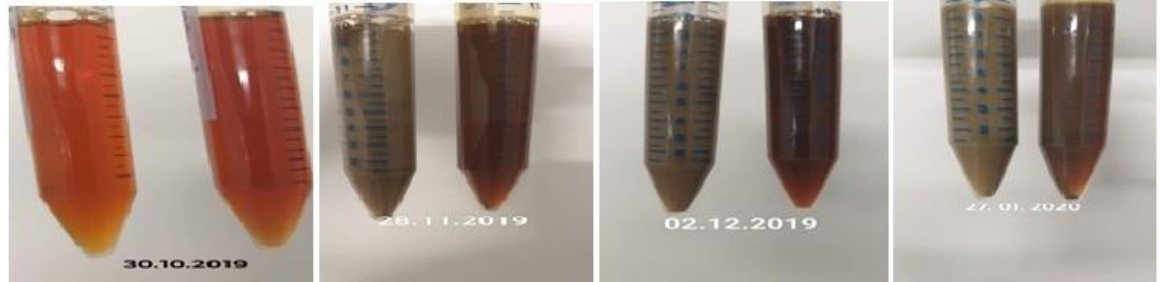
Figure 3. The change in the color of nano-suspensions with the passage of time.